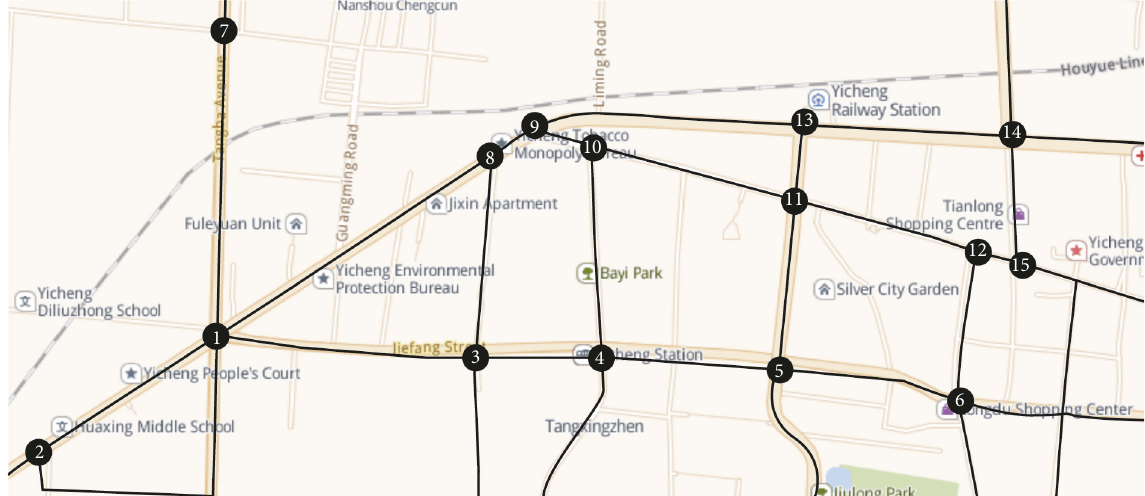
Figure 3: Road network map of Yicheng Table 1: Correlation analysis of decision indicator and route selection probability of private cars.